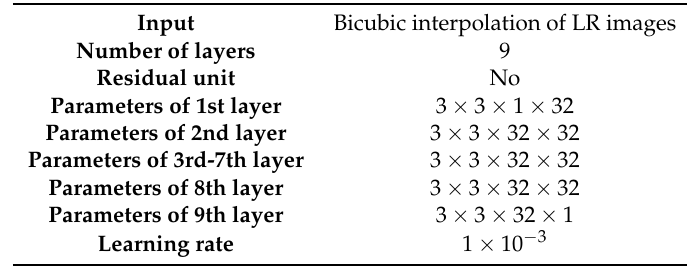
Figure 4. Network structure of DRCN used in this paper. Table 4. Parameters of DRCN used in this